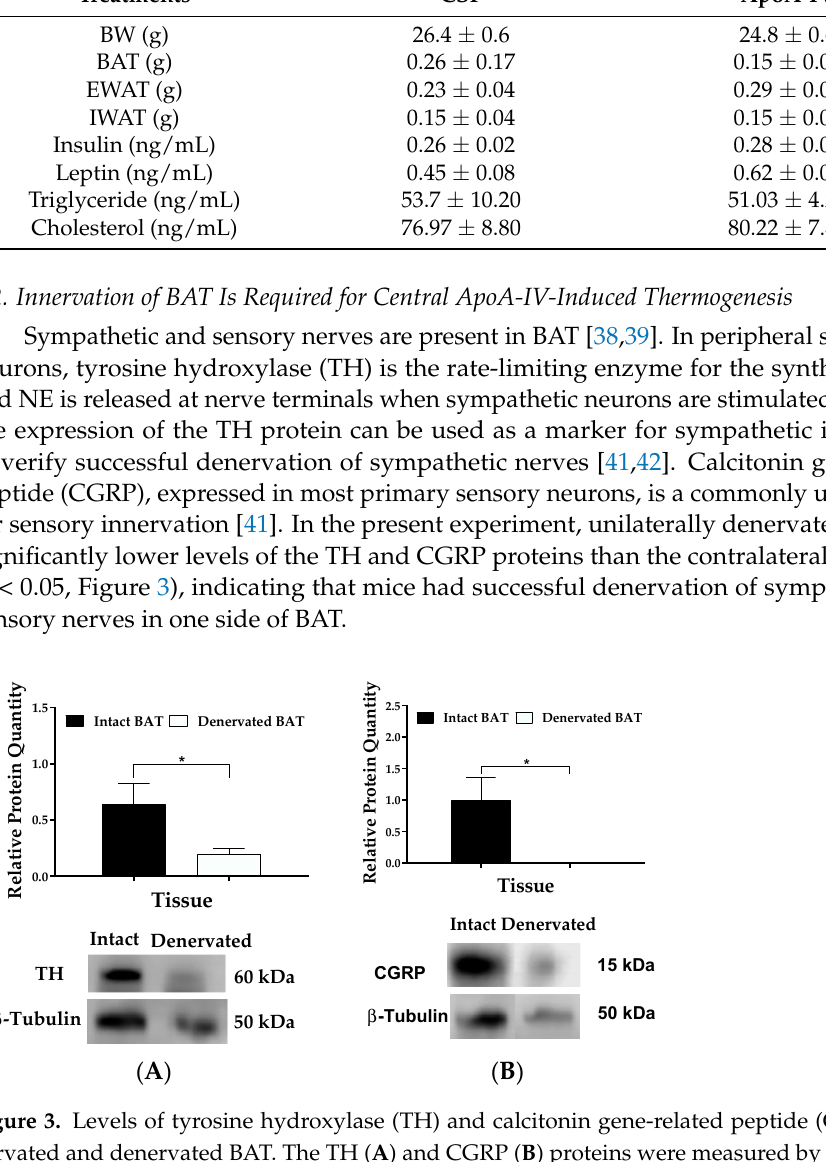
Figure 3. Levels of tyrosine hydroxylase (TH) and calcitonin gene-related peptide (CGRP) in in- nervated and denervated BAT. The TH ( A ) and CGRP ( B ) proteins were measured by immunoblot analyses. Mice with unilateral denervation of BAT received central administration of either CSF (1 µL) or ApoA-IV (12 µg in 1 µL) into the third ventricle, and BAT was collected at 40 min post- injection. Data are expressed as the means ± SEM for 10–11 mice per group. * Represents a significant difference relative to CSF-treated BAT ( p <